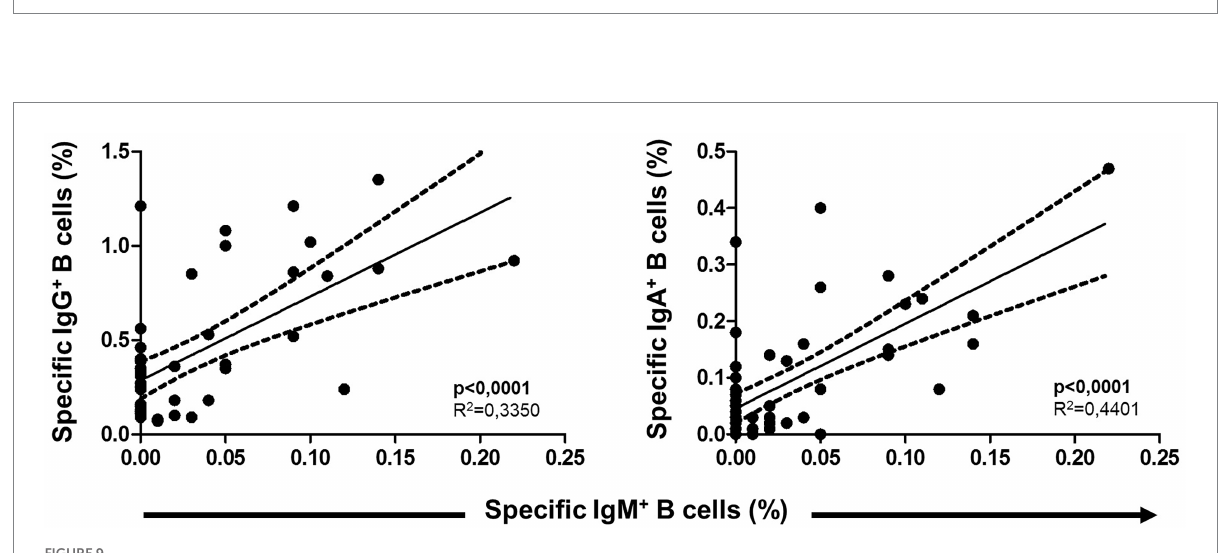
FIGURE 9 Association between specific IgM + B cells (unswitched) with both switched IgG + and IgA + B cells. Pearson’s correlation r value and two-tailed p values are